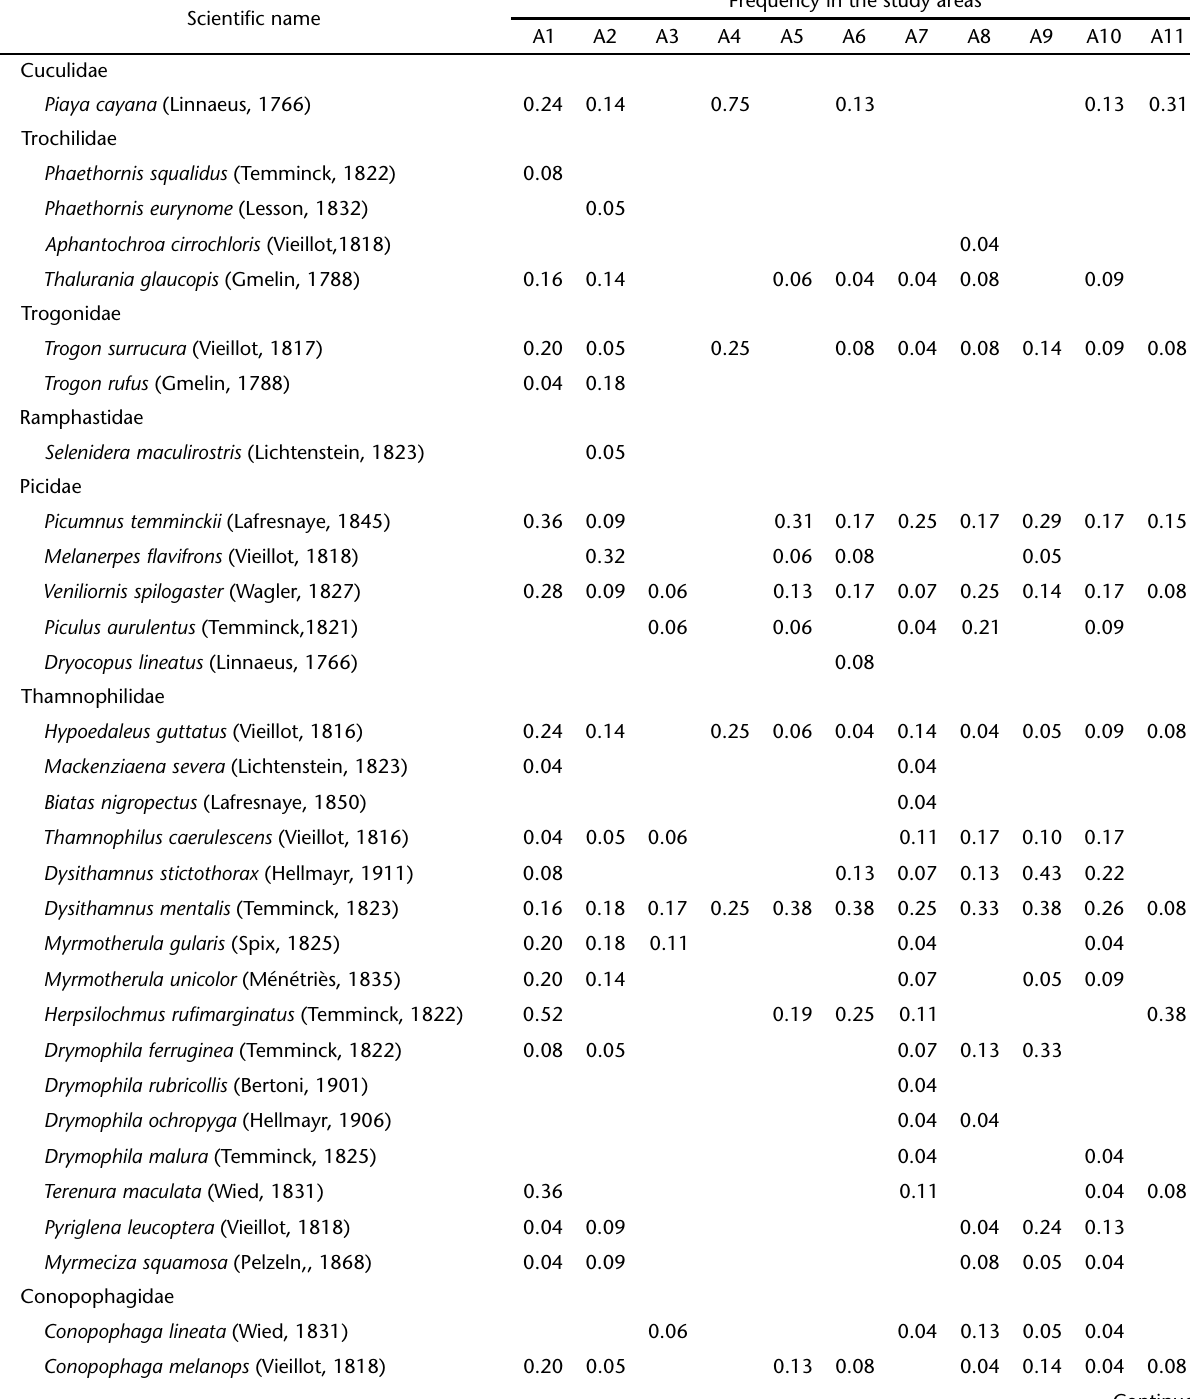
Table II. Species participating in mixed-species bird flocks sampled from remnants of the Atlantic Forest of the Hydrographic bay of the Itajaí River, Santa Catarina, between April and August, 2007. Scientific